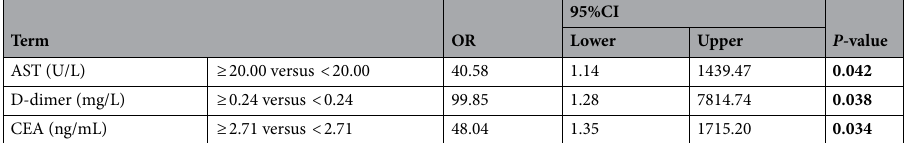
Table 4. Multivariate logistic regression analysis of ORR in patients. ORR, objective response rate; OR, odds ratio; CI, confidence interval; AST: CEA: carcinoembryonic antigen. Significant values are in [bold].